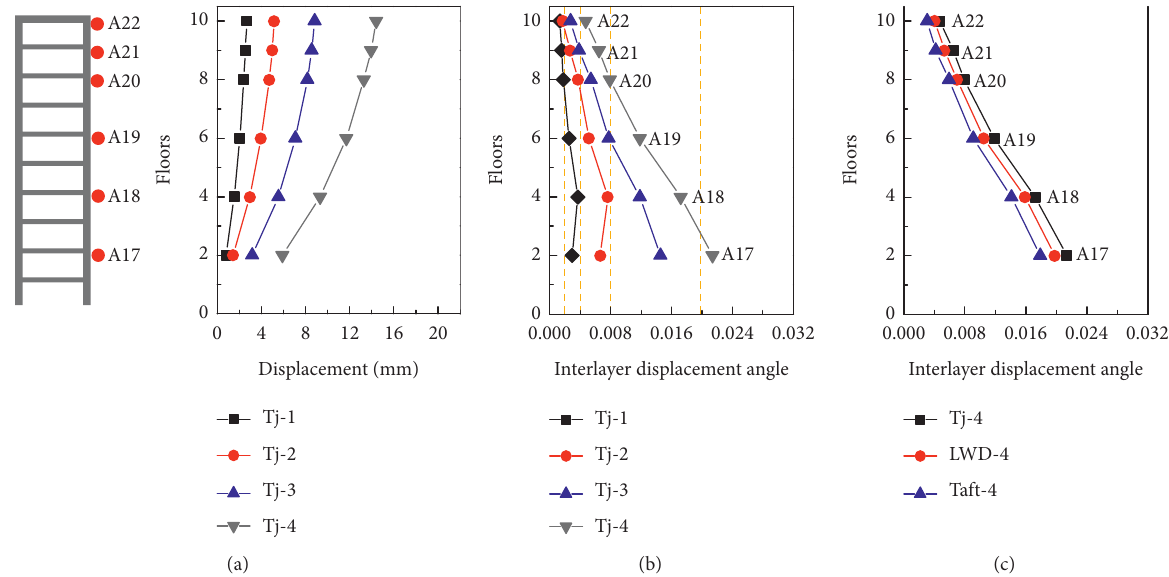
Figure 13: Displacement response of the surface structure under different test cases. (a) Displacement under Tianjin wave. (b) Interlayer displacement angle under Tianjin wave. (c) Interlayer displacement angle under different seismic waves.